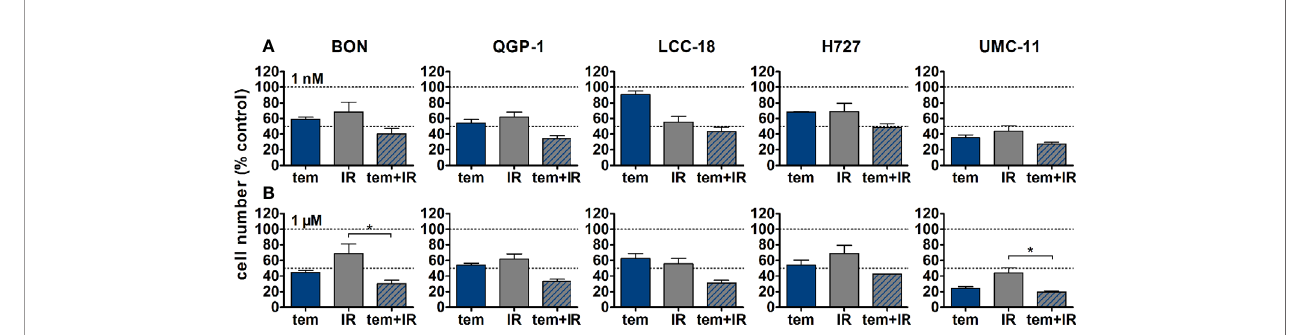
FIGURE 7 | Detailed analysis of cell numbers for combined treatment of temsirolimus and 4 Gy. NEN cell lines were pretreated with 1 nM (A) or 1 µM (B) temsirolimus for 24 h before irradiation with 4 Gy. Cell number was determined 96 h after irradiation. Graphs show mean ± S.E.M. (n=2 – 3). Evaluated with one-way ANOVA (Kruskal-Wallis test) and Dunn ’ s posttest, *P ≤ 0.05. tem, temsirolimus; IR, irradiation.